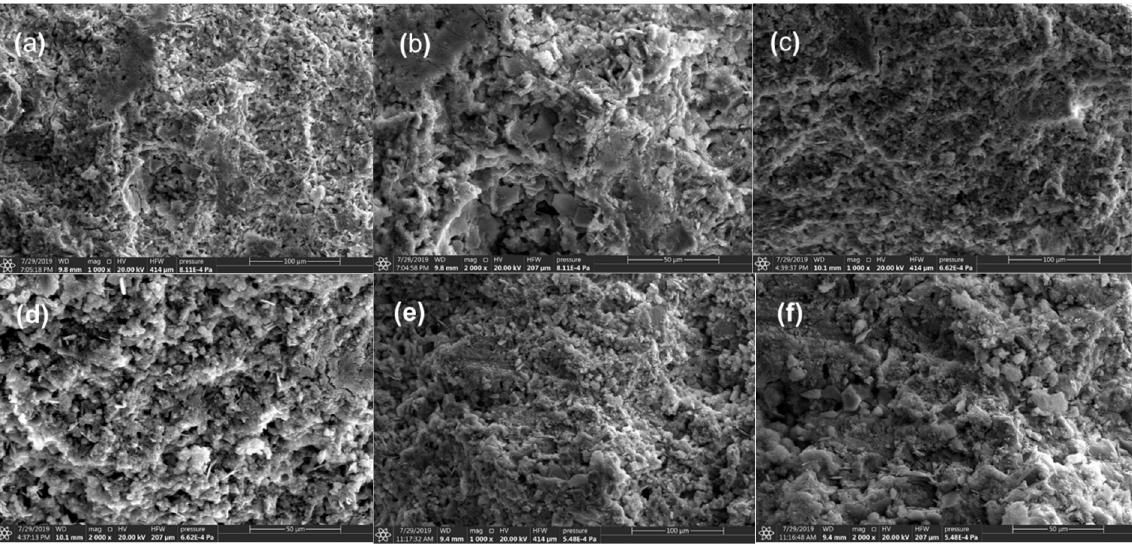
Figure 17. SEM photos of 28-day hardened SMCG at the W/S of 1.0 ( a ) CEM II/B-M, 1000× ( b ) CEM II/B-M, 2000× ( c ) CEM II/B-M, 1.5% N, 1000× ( d ) CEM II/B-M, 1.5% N, 2000× ( e ) CEM III/B, 1.5% N, 1000× ( f ) CEM III/B, 1.5% N, 2000×.